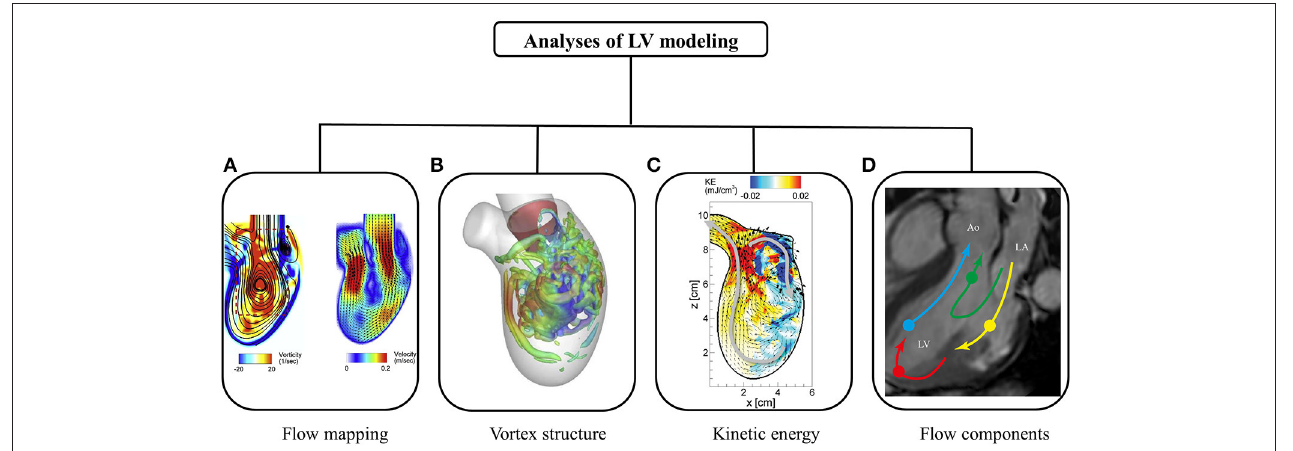
FIGURE 5 | Post-processing of intra-cardiac flow showing (A) flow mapping (Seo et al., 2014); (B) vortex structure (Seo et al., 2014); (C) kinetic energy (Seo and Mittal, 2013); and (D) flow component (Svalbring et al., 2016).